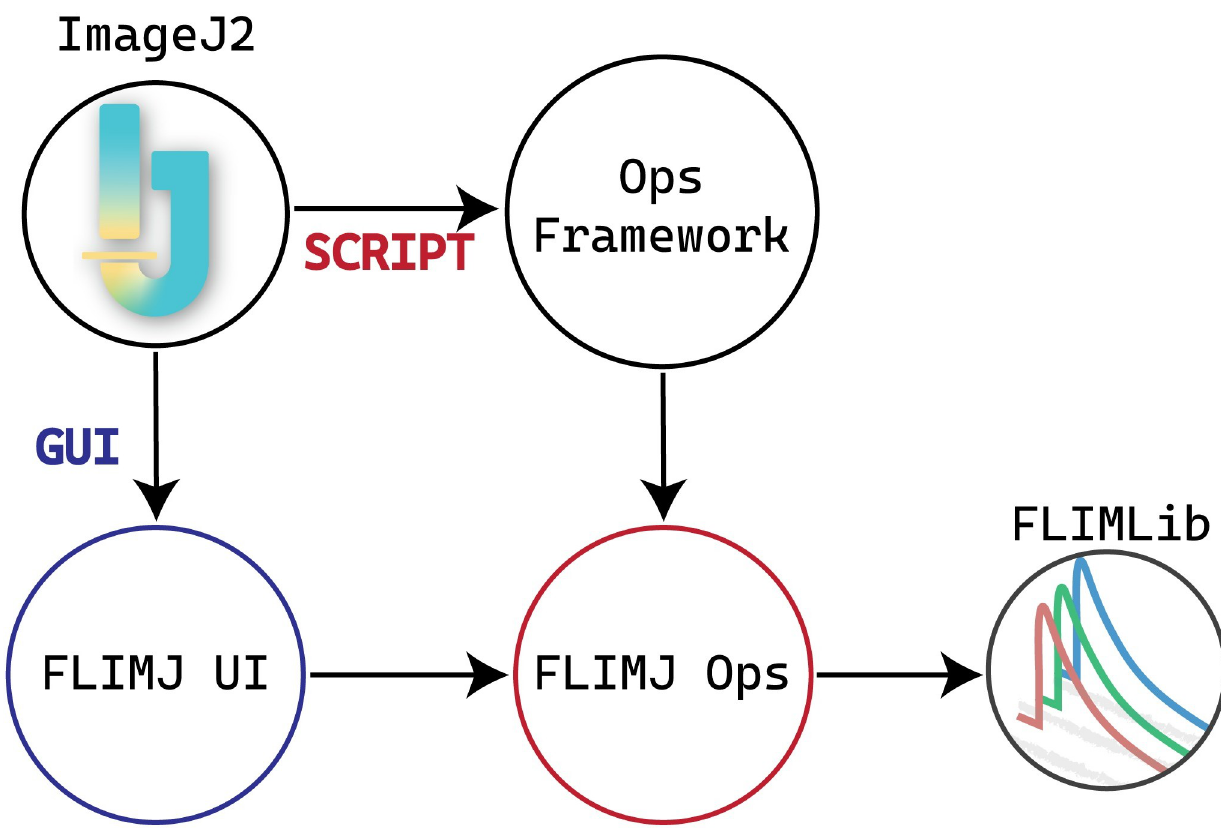
Fig 1. Relationships between components of FLIMJ and ImageJ2. FLIMJ Ops depends on FLIMLib and communicates with other supporting ops (mathematical, statistical, and input/output tools) through the Ops framework. This schematic shows two different ways to access FLIMLib. The scripting path goes through the ops-framework to the FLIMJ-Ops library, and the GUI path goes through the FLIMJ-UI to FLIMJ-Ops.